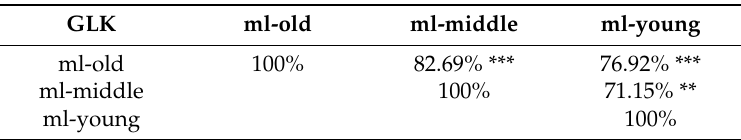
Table 2. Gleichläufigkeit (GLK) correlation of chronologies from three age-classes of Schrenk spruce trees during 1960–2012 in the eastern Tianshan Mountains.